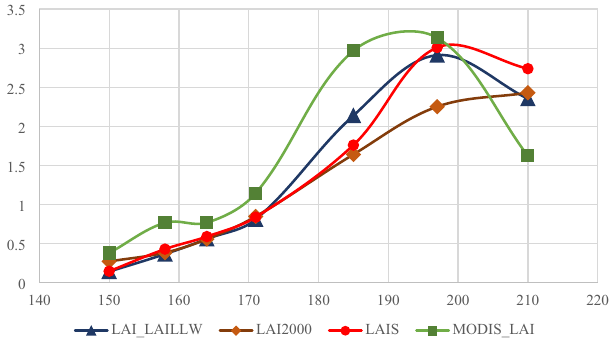
Figure 9. Variation curves of different LAI products in different observation